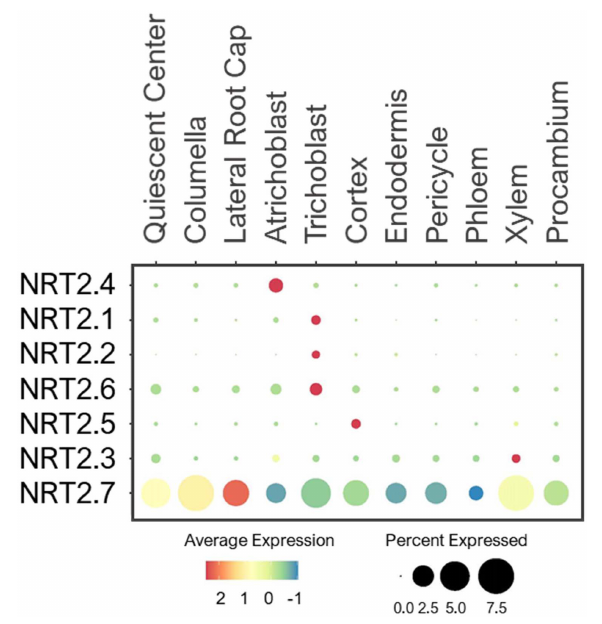
NO 3 − accumulation into vacuoles (Geelen et al., 2000; De